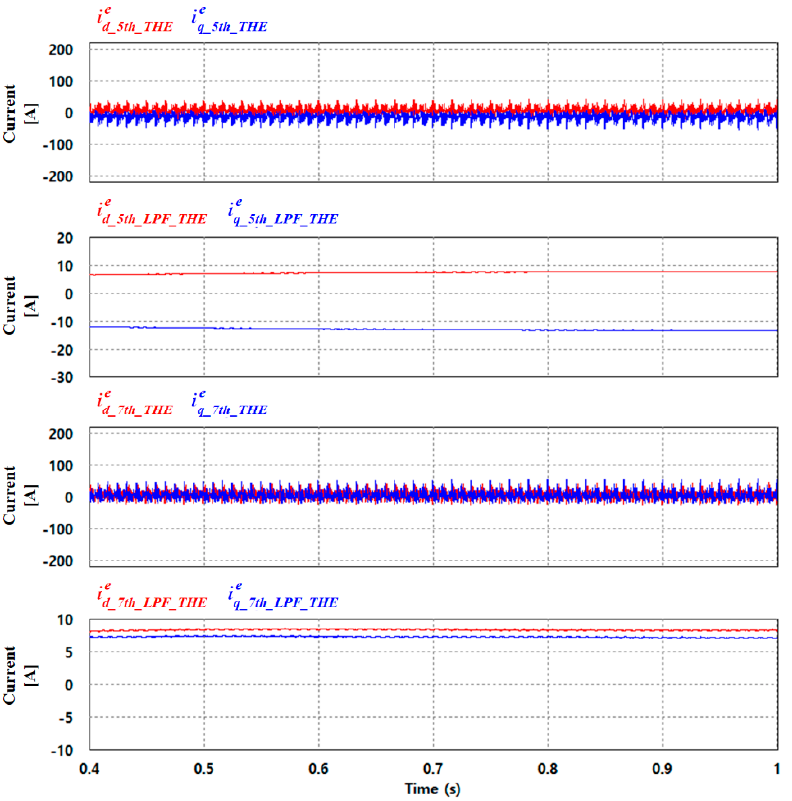
Figure 8. Harmonic currents extracted using the THE method.